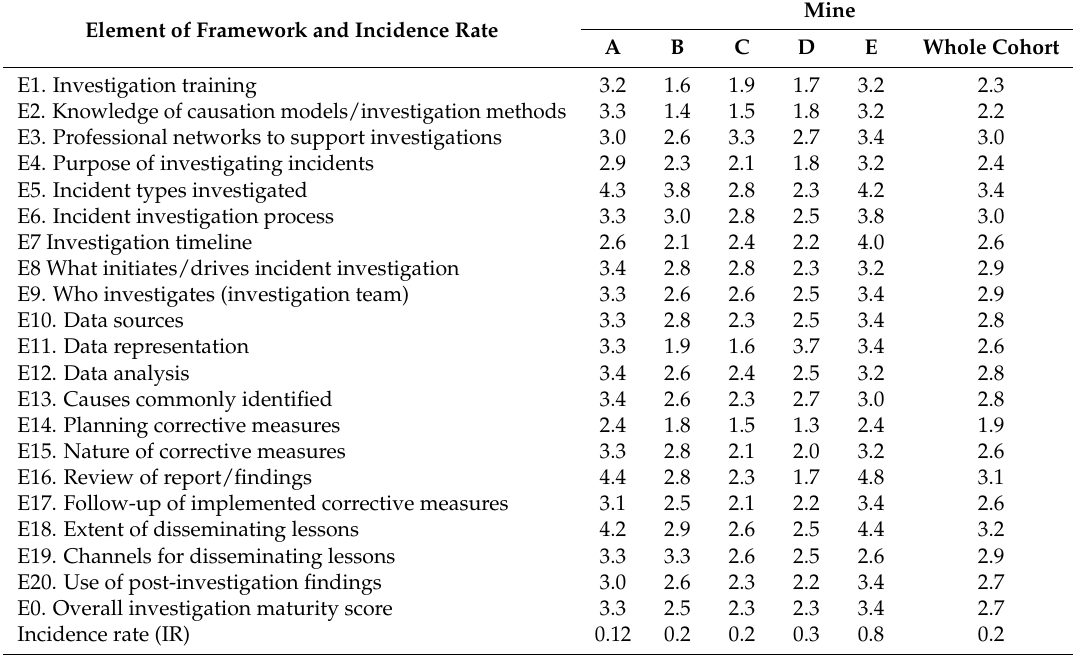
Table 4. Mean value of incidence rate and investigation scores across the